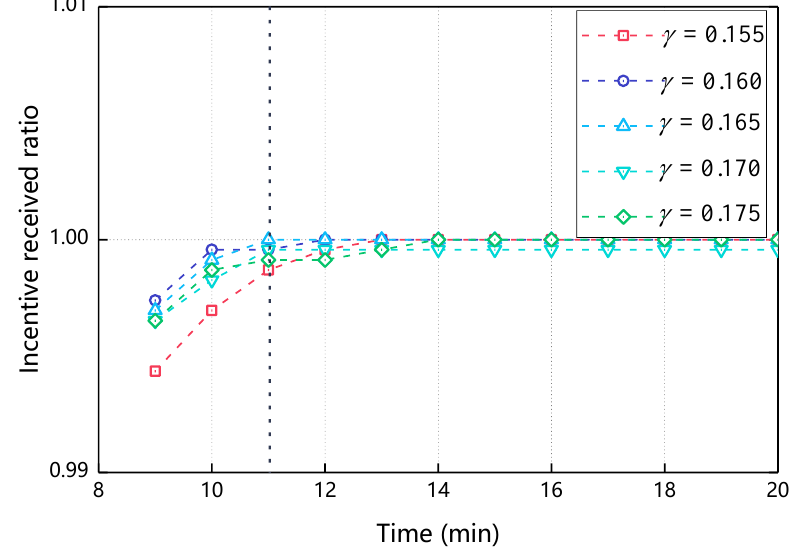
Figure 8. The impact of γ on incentive received ratio ( µ = 0.165, δ ∈ [ 0.1,0.9 ] , β ∈ ( 0,0.9 )